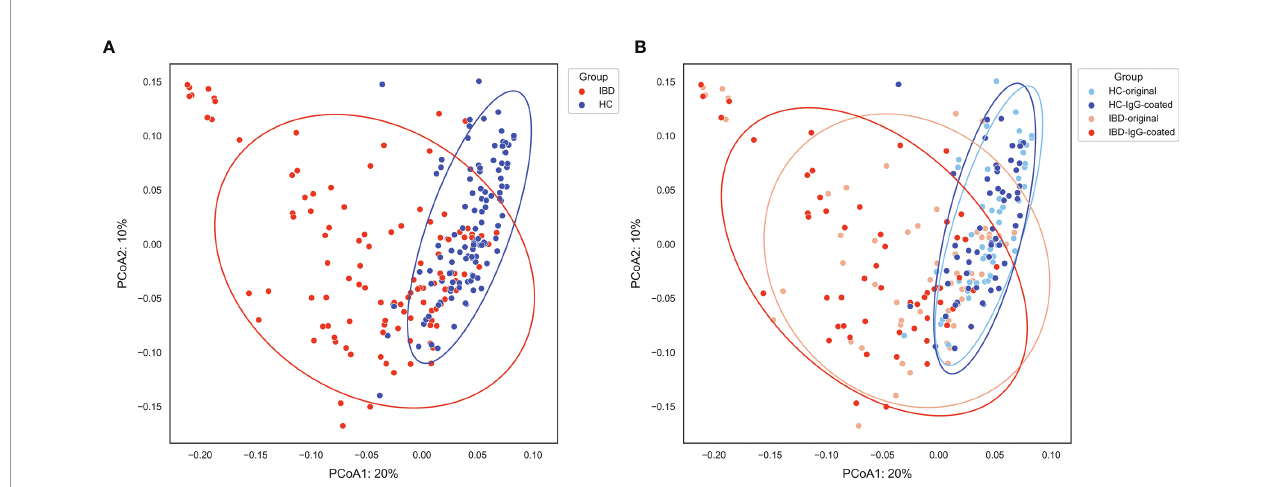
FIGURE 2 | (A, B) Principal coordinate analysis (PCoA) of fecal samples from patients with IBD (orange) and HC (blue) visualizing the beta-diversity of the gut microbiota as represented by Bray-Curtis dissimilarities. (A) Sample origin (IBD vs. HC) shows an evident separation of the fi rst two principal coordinates, which was statistically con fi rmed (PCoA1 and PCoA2: P < 0.001). (B) Paired analysis of IgG-coated vs. untreated fecal samples showed no signi fi cant change in the fi rst two principal coordinates. Sample origin (IBD vs. HC) and sample handling (IgG-coated vs. untreated samples) signi fi cantly explained 20.5% and 2.2% of the variation in